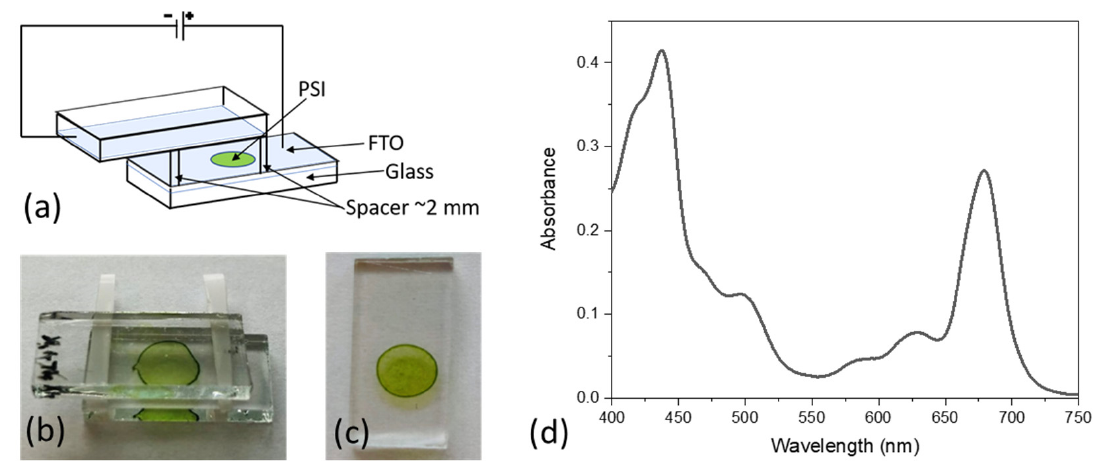
Figure 2. PSI multilayer immobilized on FTO. ( a ) Scheme of the setup for electrodeposition of PSI particles on the FTO conducting glass; ( b ) picture of the setup for the electrodeposition; ( c ) picture of the bio-photoelectrode ready to use with estimated number of ~40 PSI layers; ( d ) absorption spectrum of the bio-photoelectrode shown in panel c.